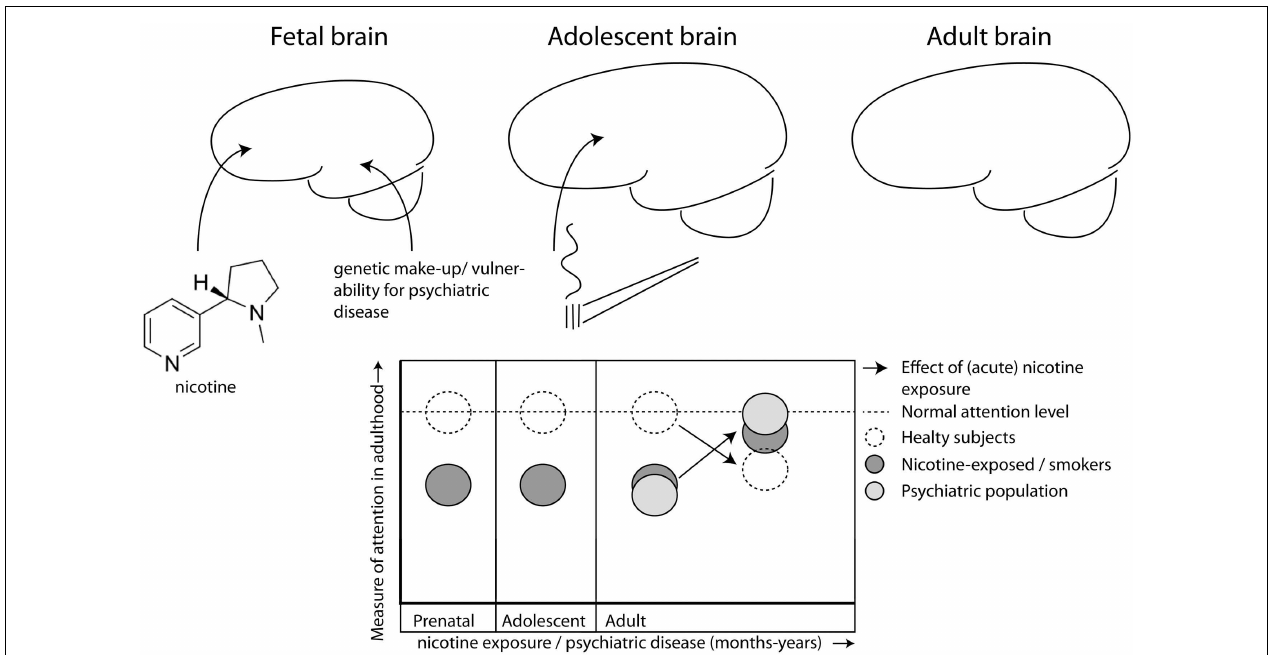
decreased attention performance. Nicotine has beneficial effects on attention, but only in those individuals who have decreased levels of attention to begin with, like smokers (Lawrence et al., 2002) and patient populations (Lerman et al., 2001; Newhouse et al., 2004), but not in healthy controls (hatched line; Levin et al., 1997, 1998;Wignall and deWit, 2011), albeit that nicotine is not always beneficial for smokers (Jacobsen et al., 2005,